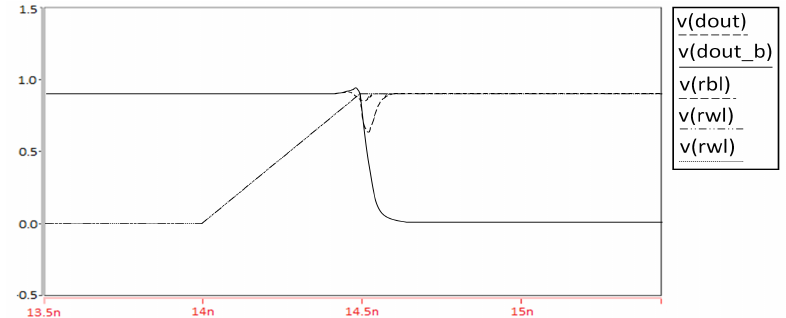
Figure 25. Waveform of Reading 1 operations in FinFET.